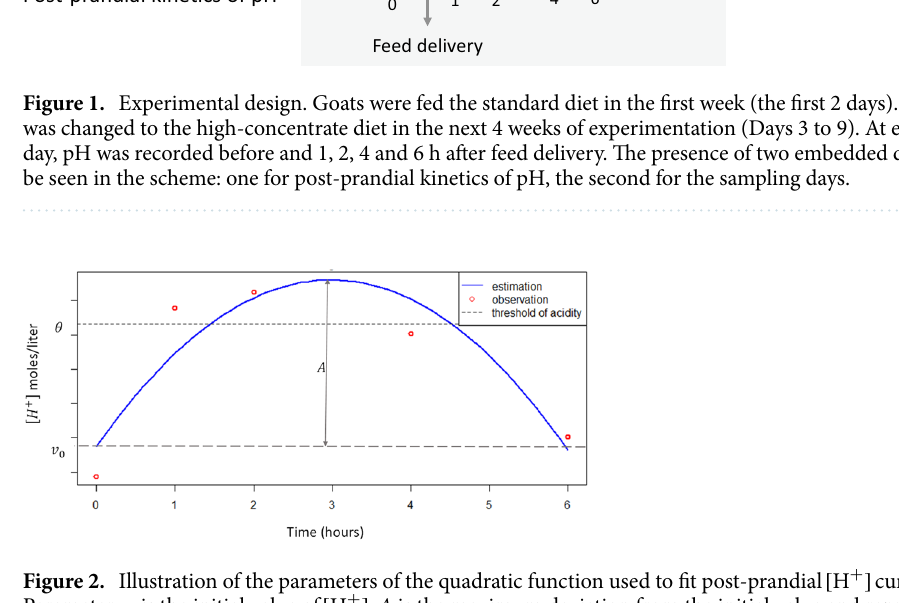
Figure 2. Illustration of the parameters of the quadratic function used to fit post-prandial [ H + ] curves. Parameter v 0 is the initial value of [ H + ] , A is the maximum deviation from the initial value and represents the difference between max [ H + ] and v 0 . Parameter R is not illustrated in the figure and is the percentage of recovery after 6 h. θ is the threshold of